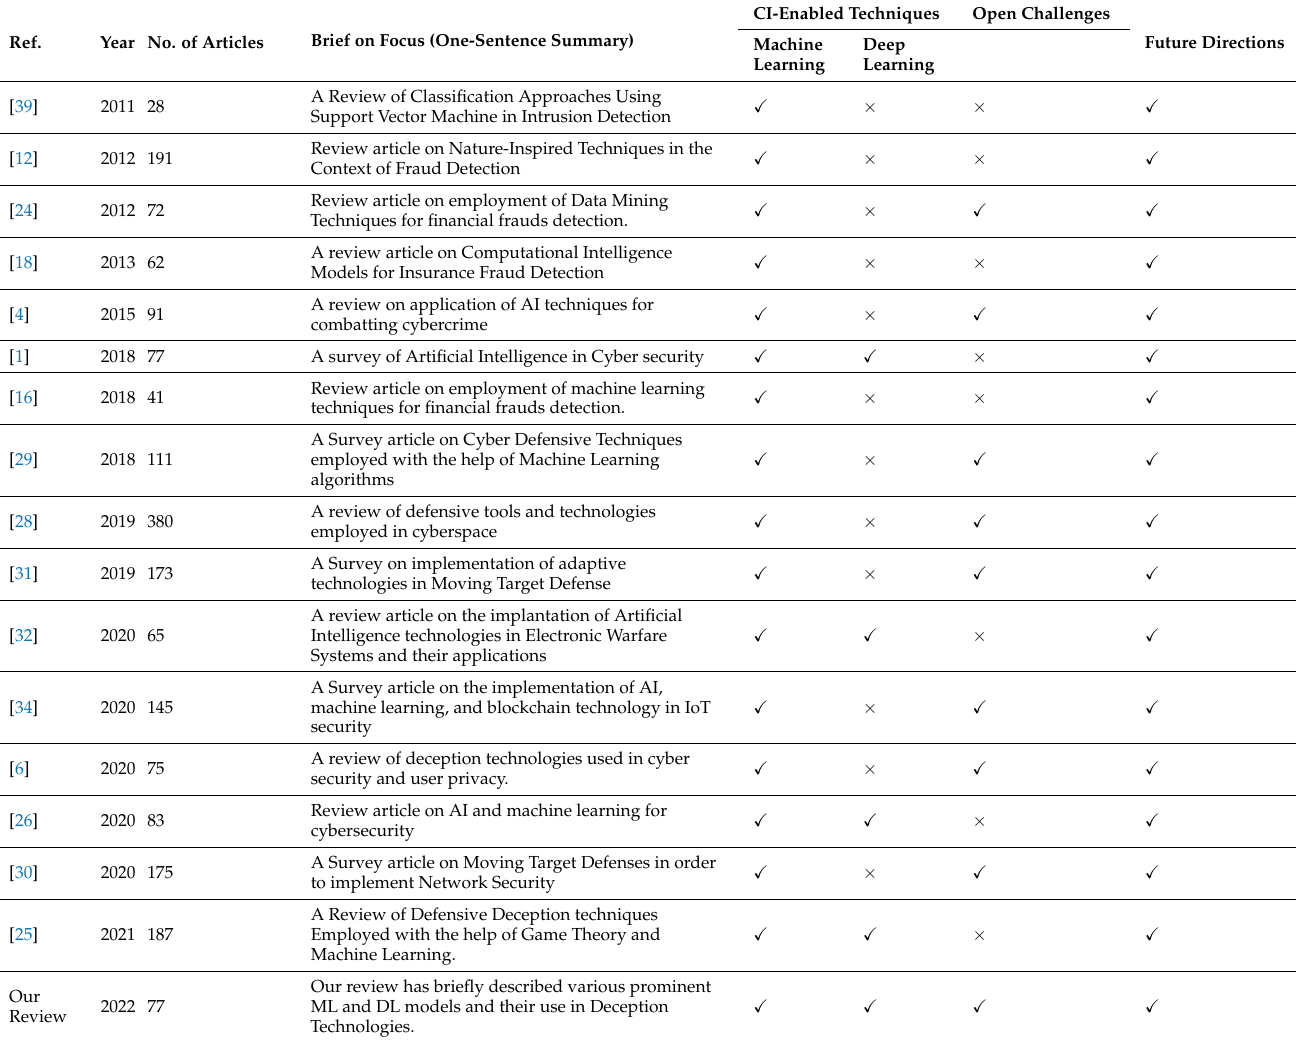
Table 1. Review articles of the CI-enabled techniques in Defensive Deception ( (cid:88) : Yes, × : No).